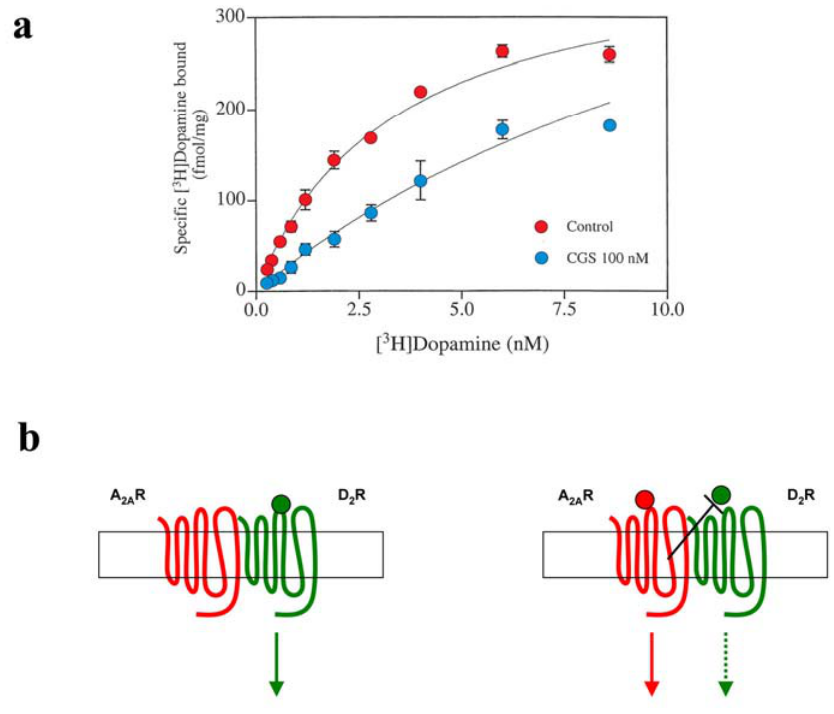
FIGURE 4. Biochemical fingerprint of the adenosine A 2A -dopamine D 2 receptor heterodimer. (a) Saturation curves of specific binding of [ 3 H]dopamine in membrane preparations from CHO cells stably cotransfected with adenosine A 2A and dopamine D 2 receptors in the presence and absence of the A 2A receptor agonist CGS 21680 (modified from Franco et al.[36]). The results show a strong modulatory effect of A 2A receptors on the affinity of D 2 receptors for dopamine (K D values in the absence and presence of CGS 21680 were 3.3 and 15.3 n M , respectively; results represent means ± SD of triplicate data). (b) Scheme of the intramembrane interaction between A 2A and D 2 receptors in the A 2A -D 2 receptor heterodimer. Stimulation of A 2A receptors decreases the ability of dopamine to stimulate D 2